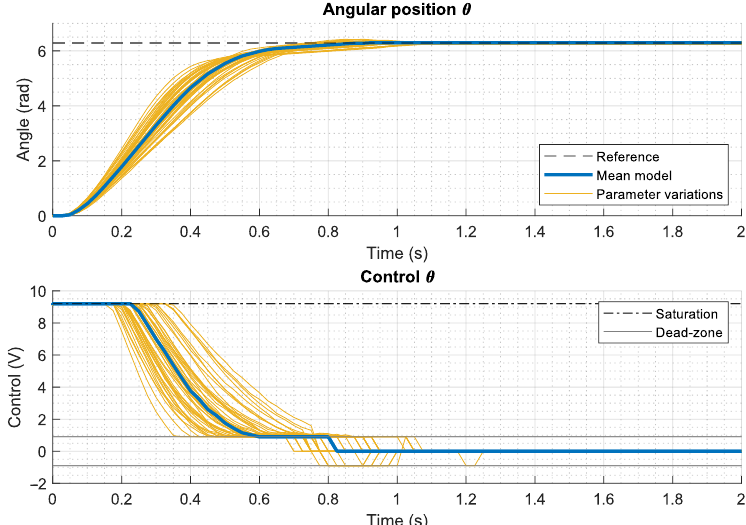
Figure 15. Simulations considering random 20% model parameters